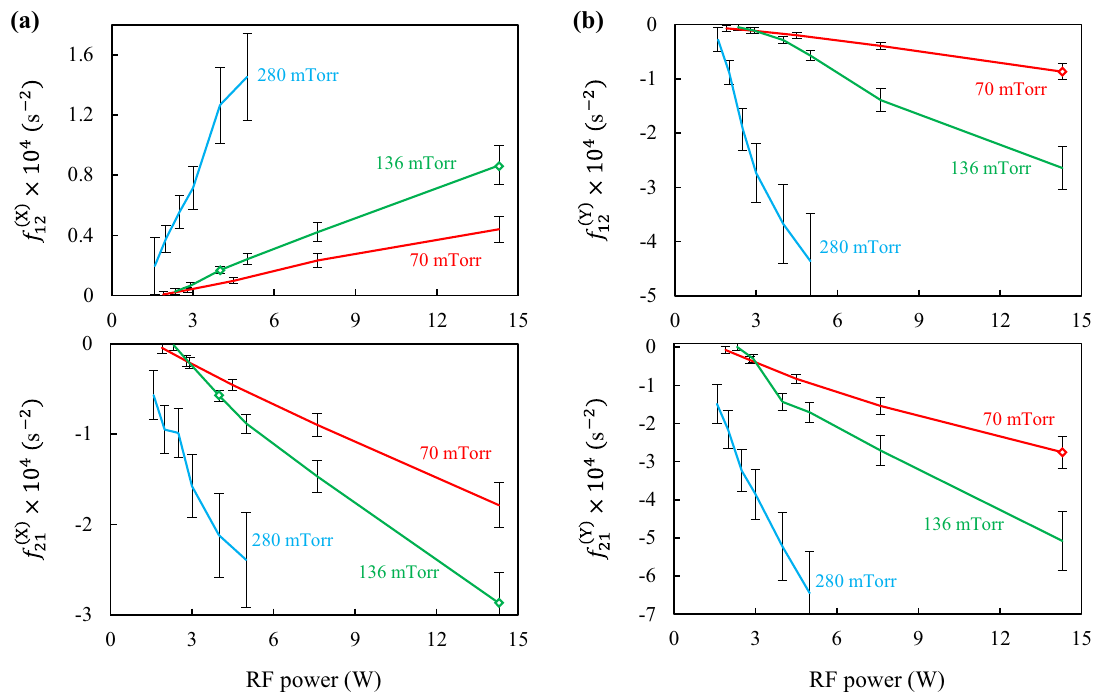
Figure 6. Derivatives of the specific interaction forces f powers in the X direction ( a ) and in the Y direction ( b ). Diamonds denote the experiments, for which the spectral densities are presented in Fig.